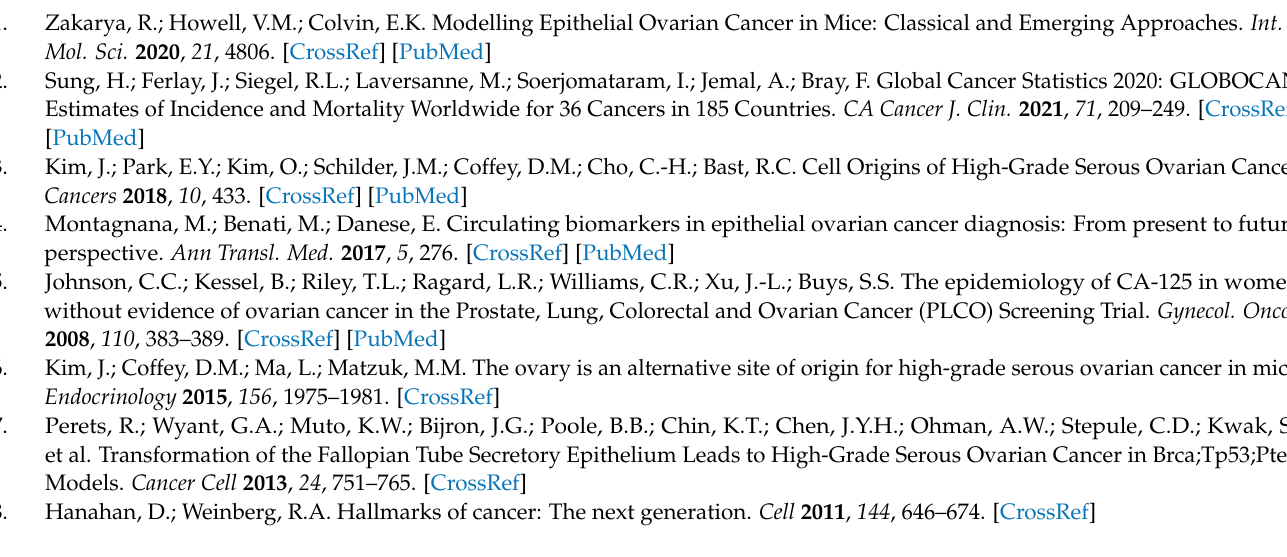
optimized feature sets. Figure S12. Comparison of serum lipid ratios for various %lifetimes in TKO and TKO control animals. Figure S13. Pathway analysis of HILIC data. Figure S14. Unsupervised Principal Component Analysis (PCA). Table S1. Composition of internal standards used in UHPLC- MS. Table S2. Chromatographic gradients for RP and HILIC methods. Table S3. MS parameters. Table S4. Serial serum collection information. Table S5. Age of TKO and TKO control mice with their corresponding %lifetime values. Table S6. Annotated compounds with statistically significant differential abundances in the RP dataset. Table S7. Metabolite annotations for the 46 selected features in the HILIC dataset. Table S8. Pathway analysis results obtained from Lipid Pathway Enrichment Analysis (LIPEA) of RP data. Reference in supplementary